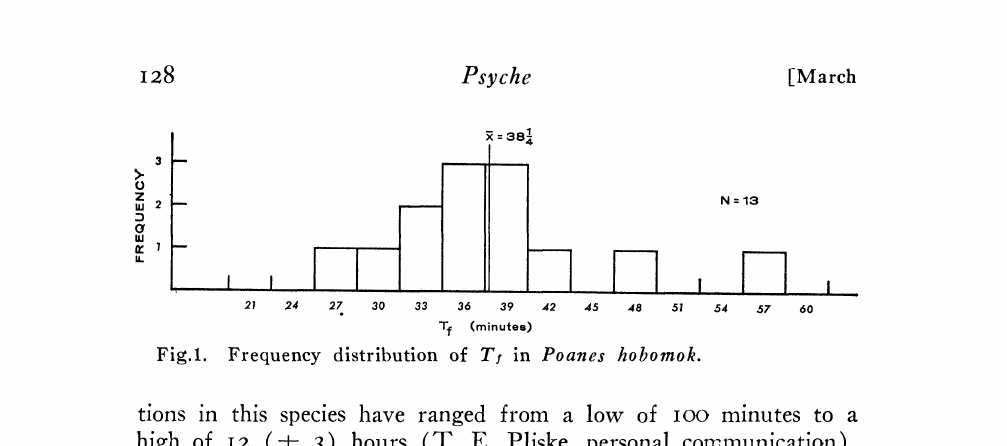
Fig.1. Frequency distribution of Tf in Poanes